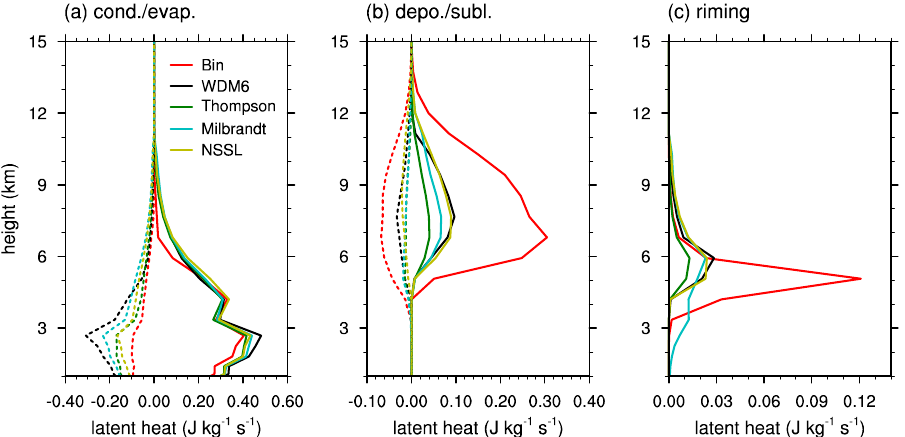
Figure 6. Vertical profiles of horizontally averaged latent heat release and absorption rates by ( a ) condensation and evaporation, ( b ) deposition and sublimation, and ( c ) riming. In ( a ), solid and dashed lines correspond to condensation and evaporation, respectively. In ( b ), solid and dashed lines correspond to deposition and sublimation, respectively.